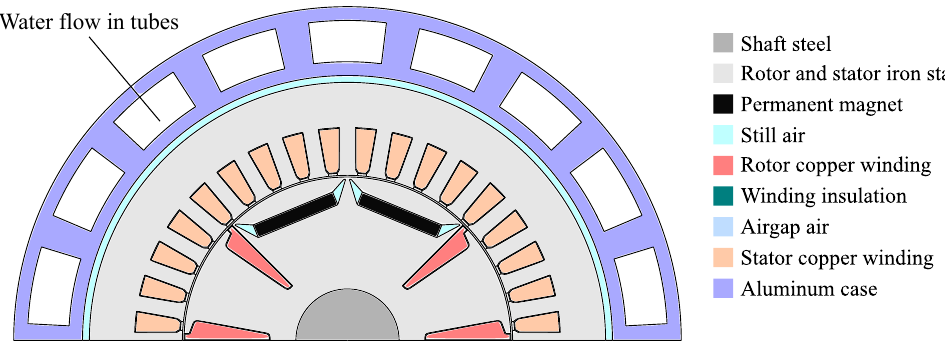
Figure 26. Motor model for the thermal finite element simulation of the HE-IPM motor with a water cooling system. Table 6. Parameters of the thermal finite element